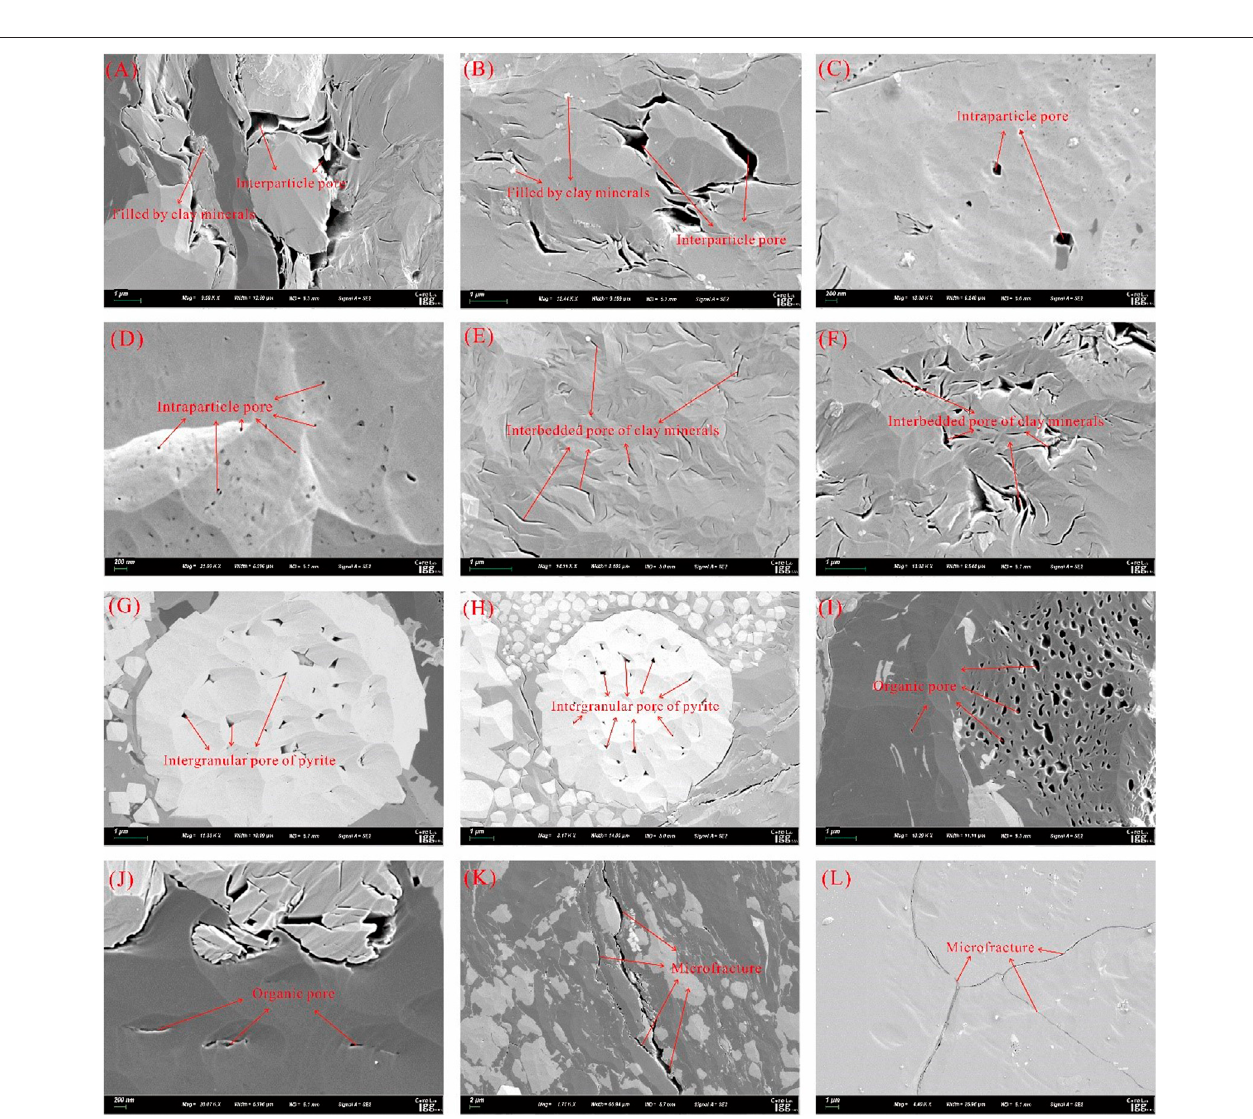
FIGURE7| Differenttypesofpores. (A,B) Interparticlepore. (C,D) Intraparticlepore. (E,F) Interbeddedporeofclayminerals. (G,H) Intergranularpore. (I,J) Organic pore. (K,L) Microfracture.